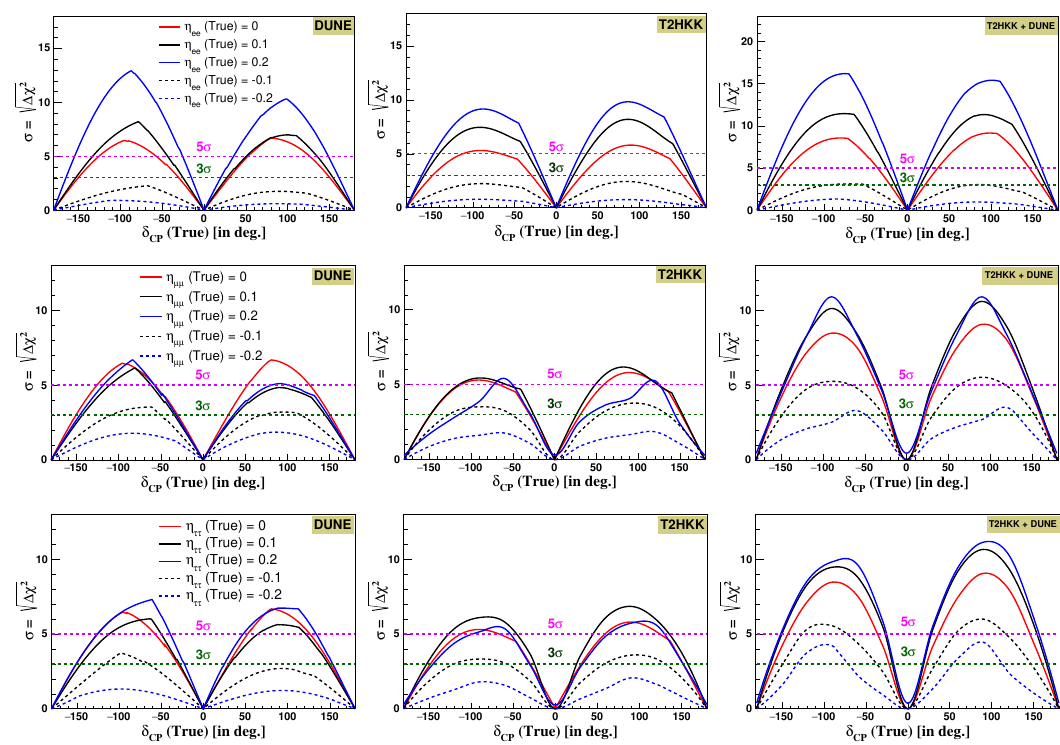
Figure 8 . The CPV sensitivity of DUNE (left-column), T2HKK (middle-column) and DUNE + T2HKK (right-column) in presence of scalar NSI. The plots for η top-row, middle-row and bottom-row respectively. The solid-red curve is for the no scalar NSI case whereas solid (dashed) black and blue curves are for positive (negative) η